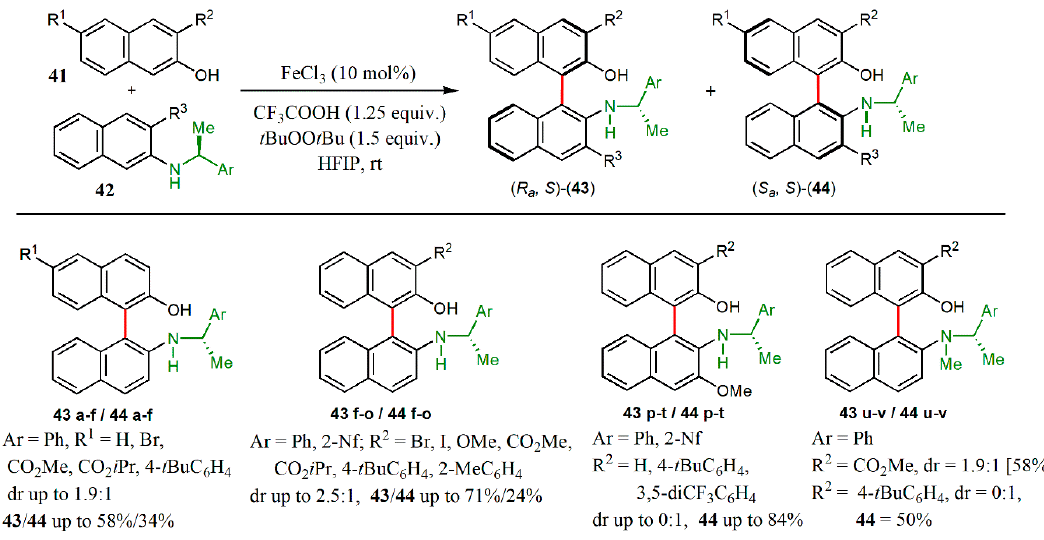
Figure 14. Iron-catalyzed stereoselective synthesis of optically pure 2-amino-2 (cid:48) -hydroxy-1, 1 (cid:48)